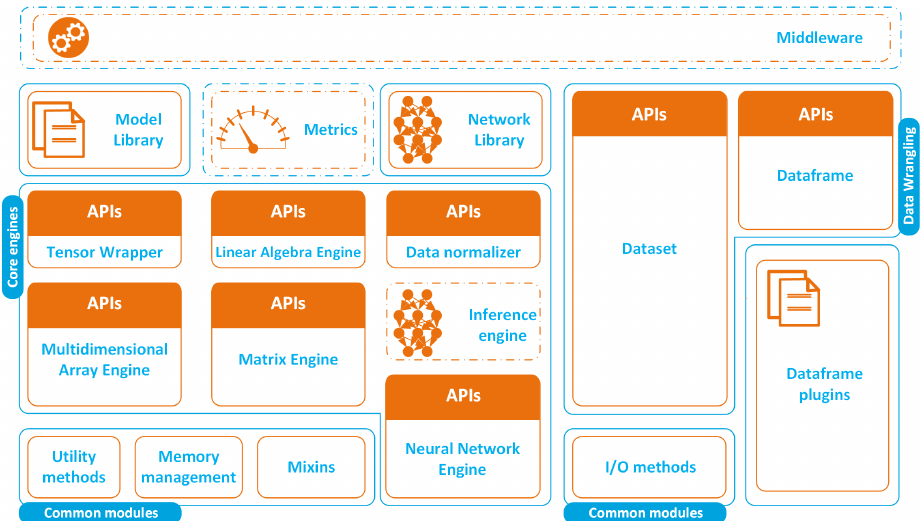
Figure 4. Software architecture of the ML framework (dotted lines denote modules still under development).